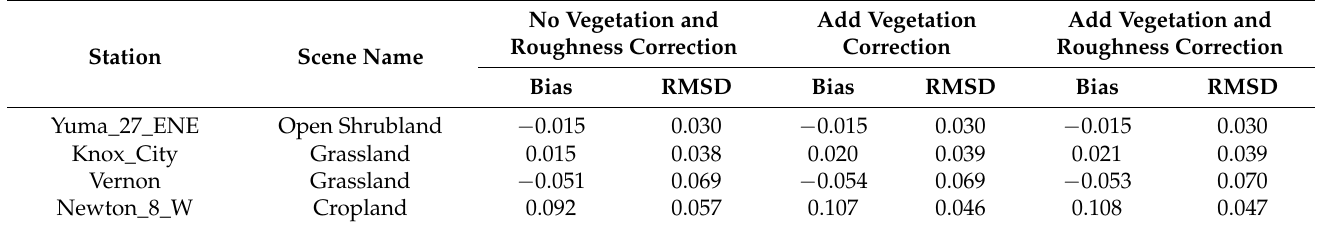
Table 2. The CYGNSS soil moisture retrieval accuracy at different in situ stations (unit: cm 3 cm − 3